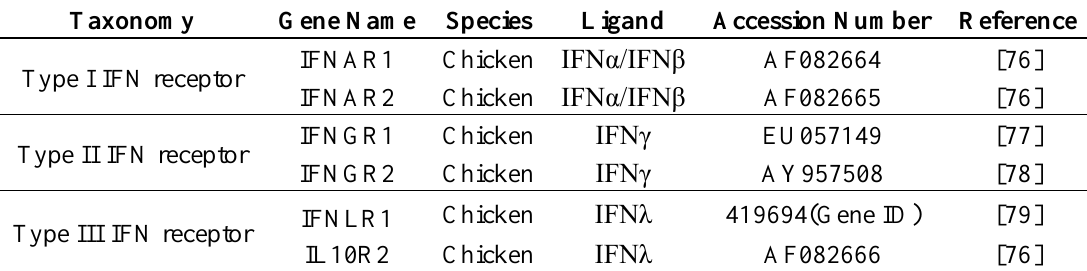
Table 4. List of the interferon receptors identified in